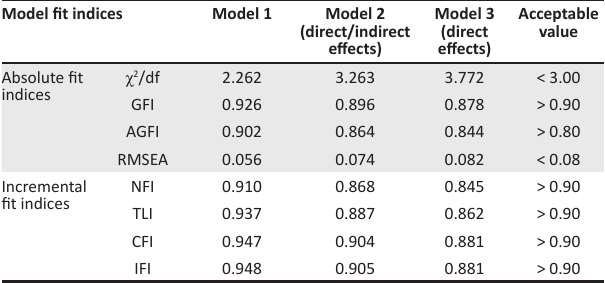
TABLE 2: Correlations between constructs. Constructs